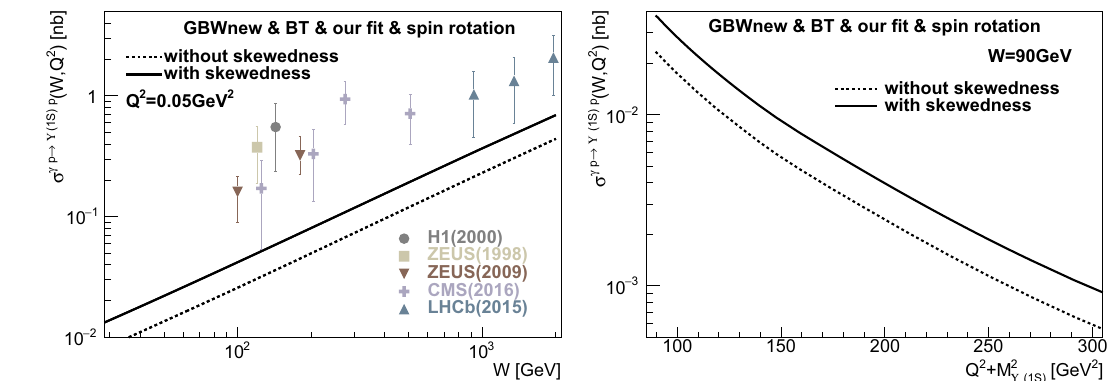
Fig. 27 The same as Fig. 26 but for exclusive electroproduction of 1 S bottomonia. The data are taken from from H1 [33], ZEUS [86,87], CMS [88] and LHCb [89]